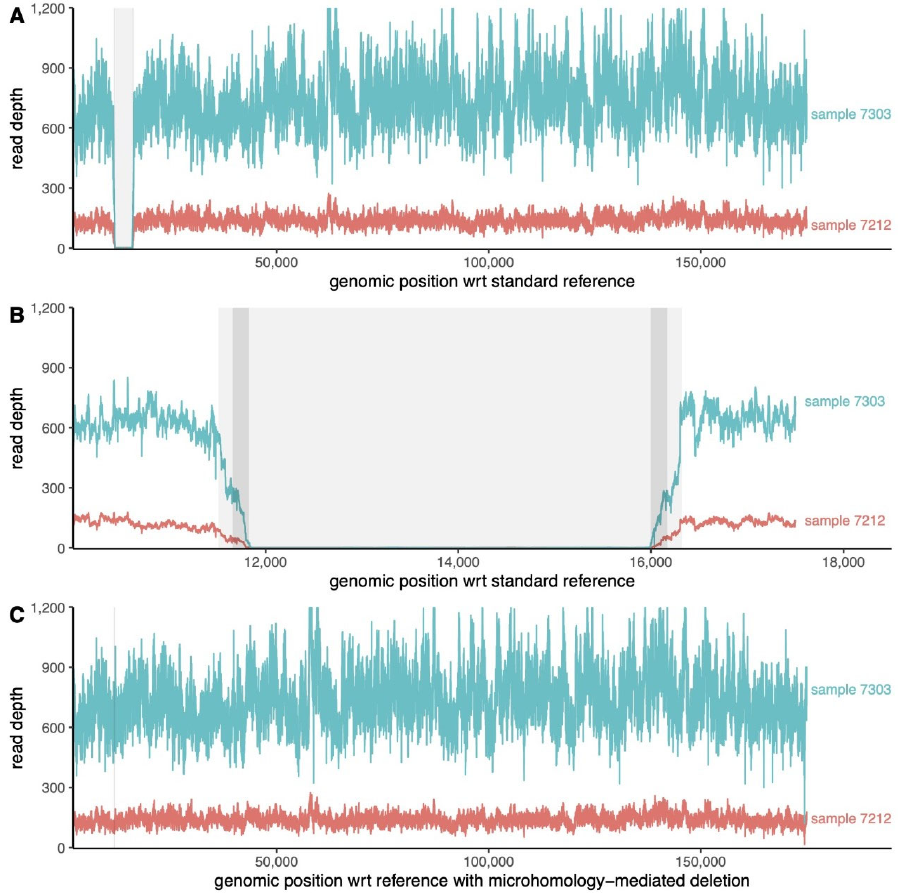
Figure 2. Read depth along the genome before read deduplication. ( A ) Depth of reads aligned to the Sardinian reference genome KX354450. The drop in read depth corresponding to the deletion is highlighted in grey. ( B ) Zoomed view centered on the region of the deletion (about 12–16 k from 5 ′ end of the genome). ( C ) Depth of reads aligned to the modified reference KX354450MMD, which included the theoretical microhomology ‐ mediated deletion.